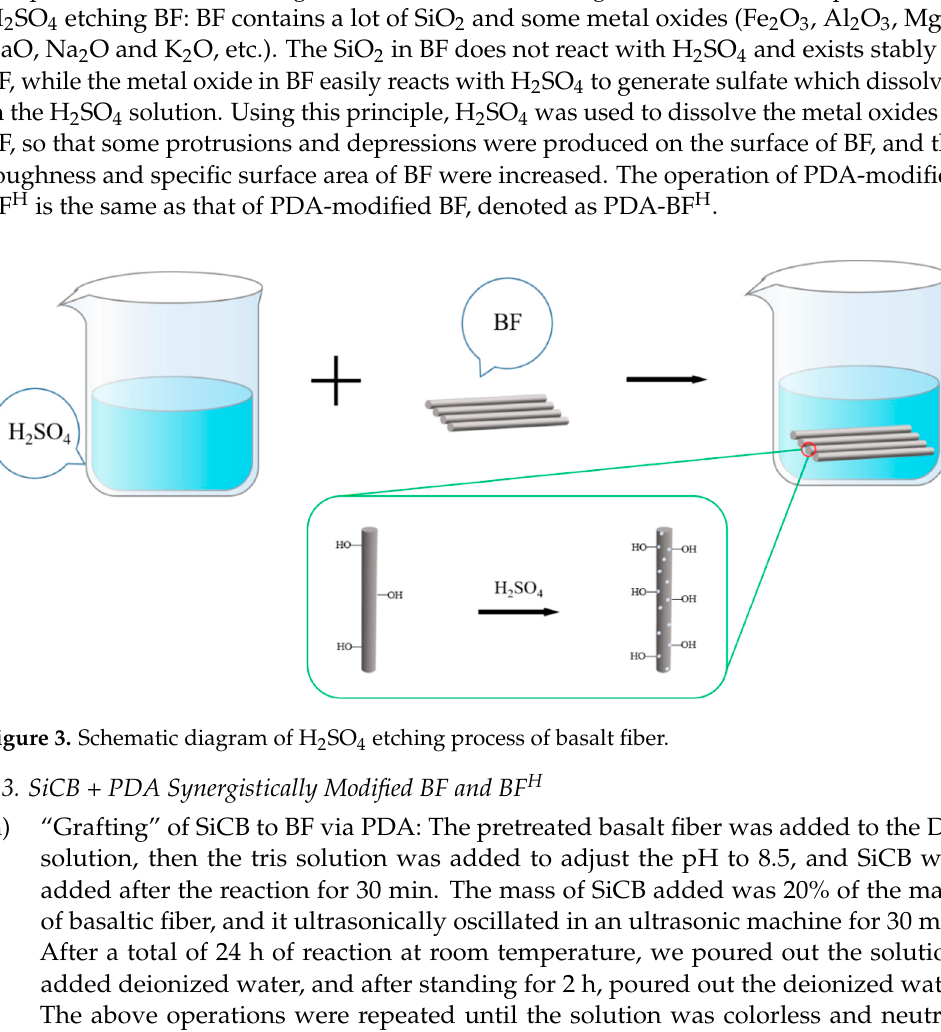
Figure 2. Mechanism diagram of PDA modified BF.